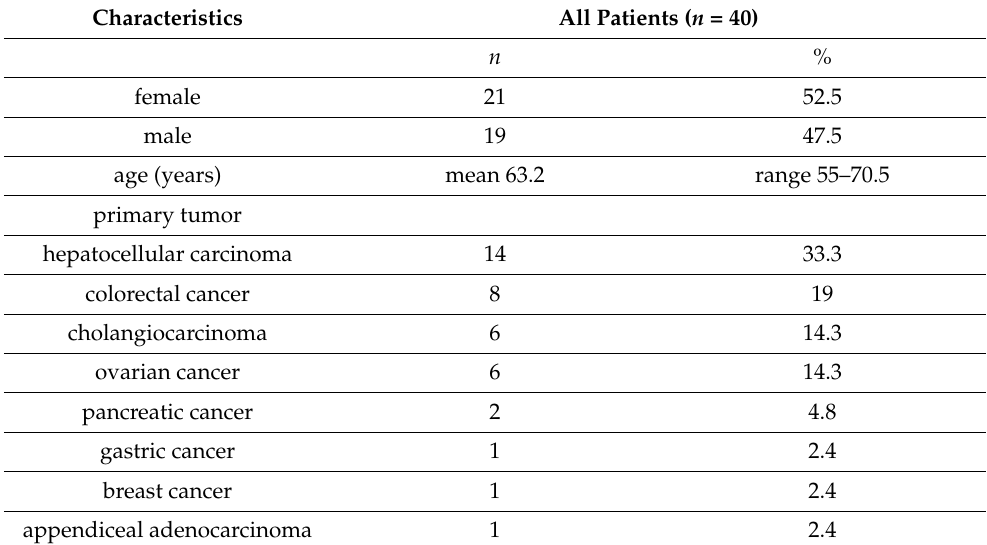
Table 2. Overview of the patient